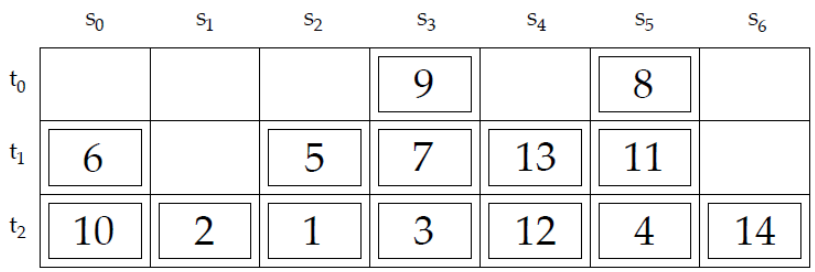
Figure 1. Yard bay with 3 tiers and 7 stacks. As can be seen in Figure 1, the containers are marked with a different retrieval priority (ordinal numbers) based on the transport documentation that specifies the departure order. The retrieval represents the lifting of the target container and loading it onto a truck or other internal transport unit [17]. Therefore, the retrieval time for each container is known in advance (offline variant). A container with a smaller number has a higher priority and must be retrieved earlier. If some container blocks access to a particular container that needs to be retrieved next, it must be relocated to another free stack within the bay.